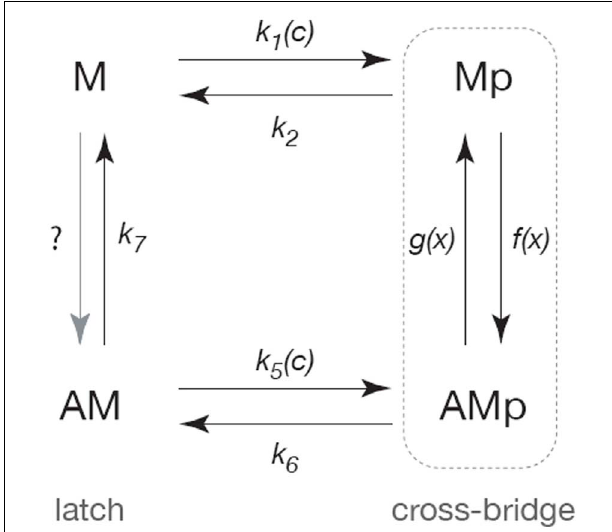
FIGURE 3 | Schematic diagram of the cross-bridge model. Following Hai and Murphy (1988) the myosin is assumed to exist in four forms; unphosphorylated and unattached (M), phosphorylated and unattached (Mp), phosphorylated and attached (AMp), attached and unphosphorylated (AM). Cycling between the Mp and AMp states generates active force, while the AM state can maintain tension but cannot generate force (and is thus called the latch-state). Rates of phosphorylation are assumed to be sigmoidal functions of Ca 2 + concentration ( c ).The rates of attachment and detachment are functions of the distance ( x ) to the actin-binding site, and thus the model is a system of partial differential equations of conservation